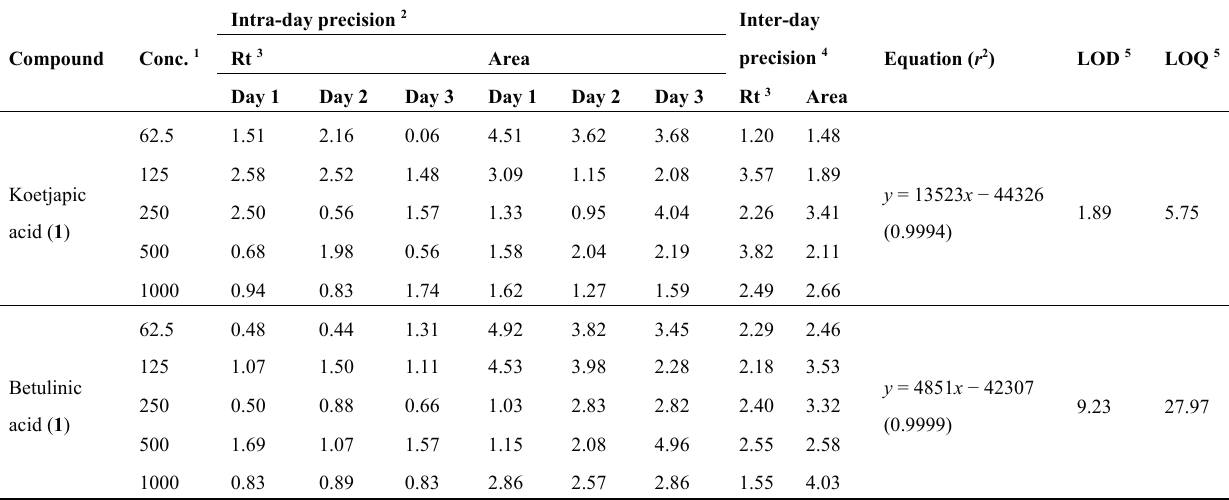
Table 4. Validation parameters of HPLC method for koetjapic acid ( 1 ) and betulinic acid ( 3 ). Compound Conc.